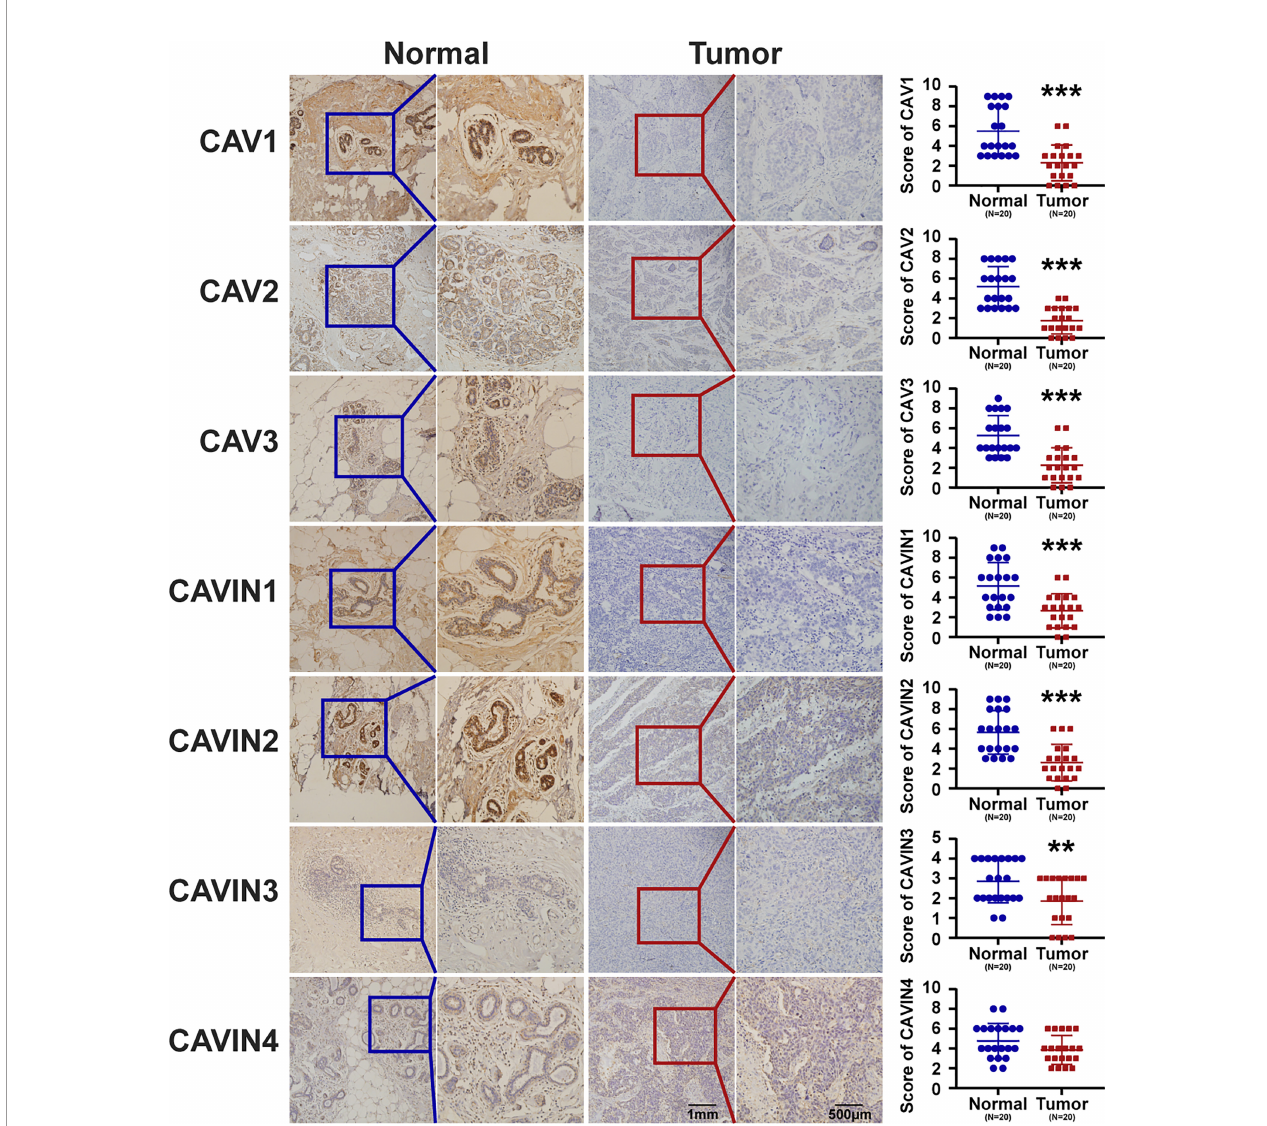
FIGURE 3 | Representative immunohistochemical images of CAVs and CAVINs in cancer tissues with paired normal samples from patients with breast cancer. 20 samples were involved for IHC analysis and the corresponding IHC scores were summarized as scatter plots on the right. (** p < 0.01, *** p <